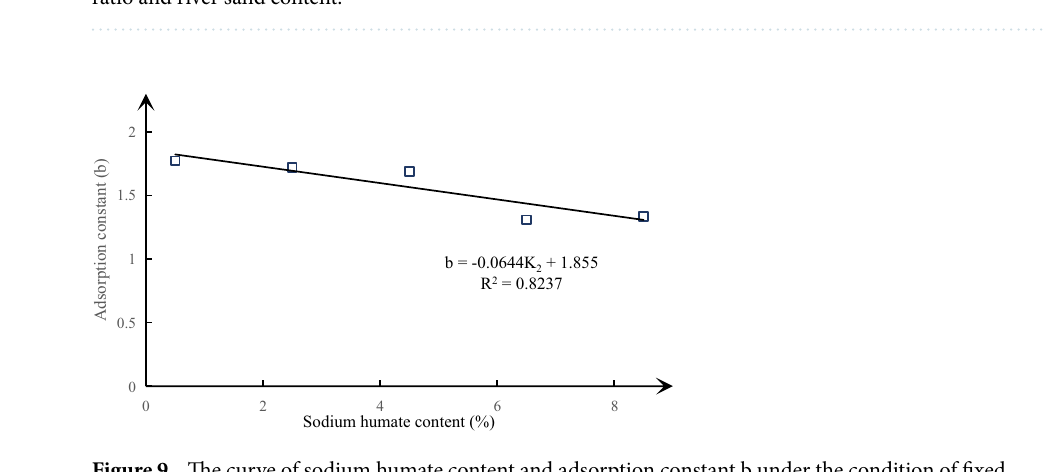
Figure 8. The curve of sodium humate and adsorption constant a under the condition of fixed pulverized coal ratio and river sand content.